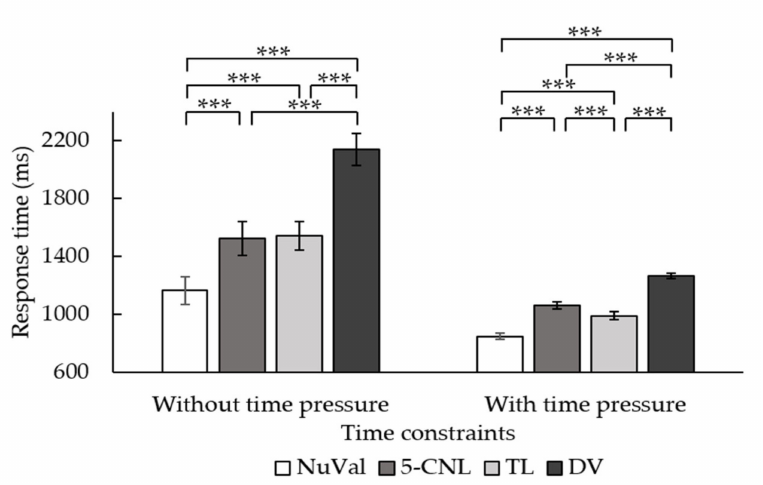
Figure 4. Interaction between the time constraints and types of nutrition labels in affecting